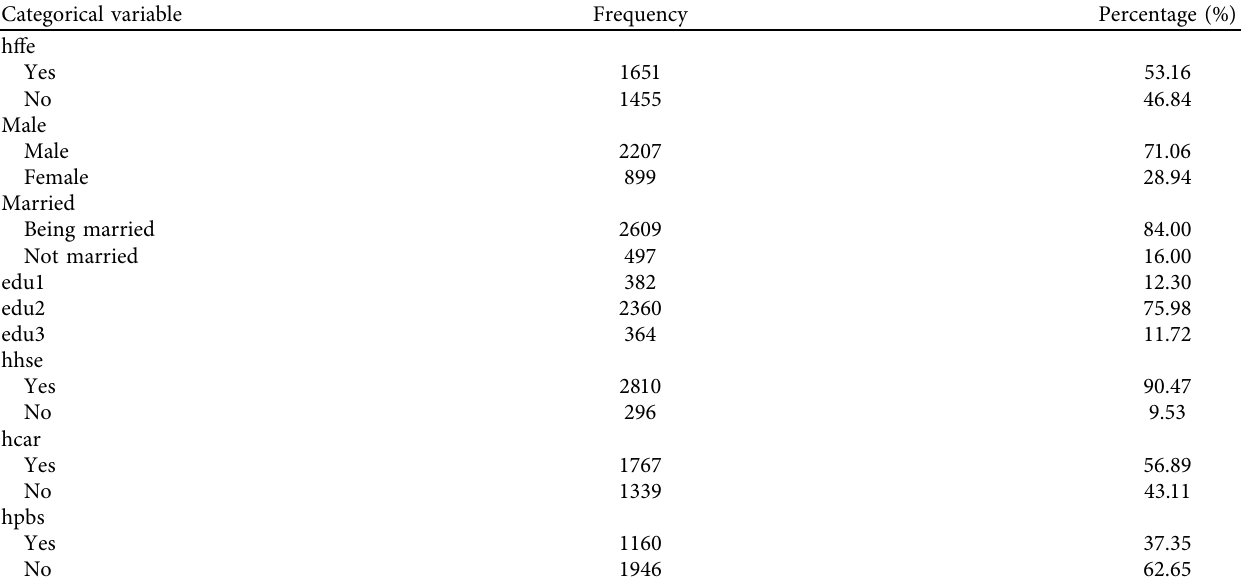
Table 3: Frequency and percentage of categorical and dummy variables.